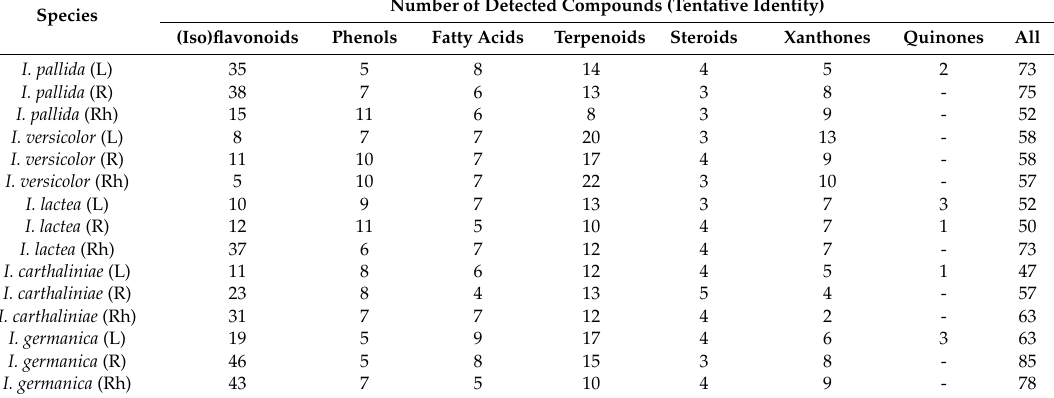
Table 1. Major chemical constituents present in assessed Iris extracts of leaves (L), roots (R), and rhizomes (Rh).